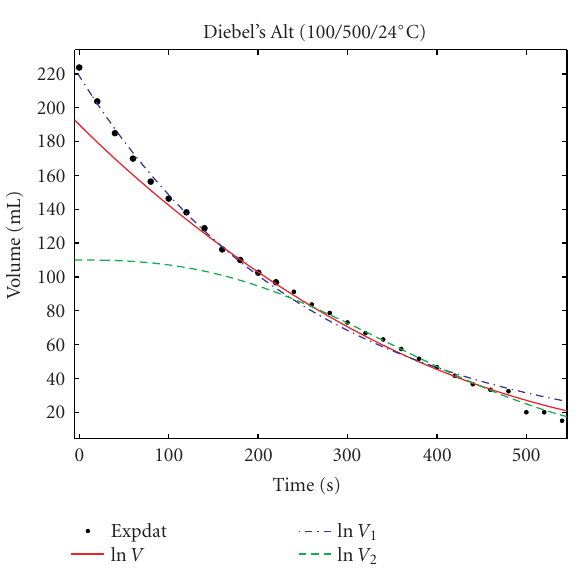
3.2. Drainage process. Dale et al. suggested that the exponential shrinking of the volume according to (3.4) is mainly caused by the drainage [8]. A first inspection seems to sup- port this idea, since the fitting curve V 1 ( t ) = exp( a 1 )exp( − b 1 t ) for the data of the initial phase I (0s ≤ t ≤ 160s) is an exponential